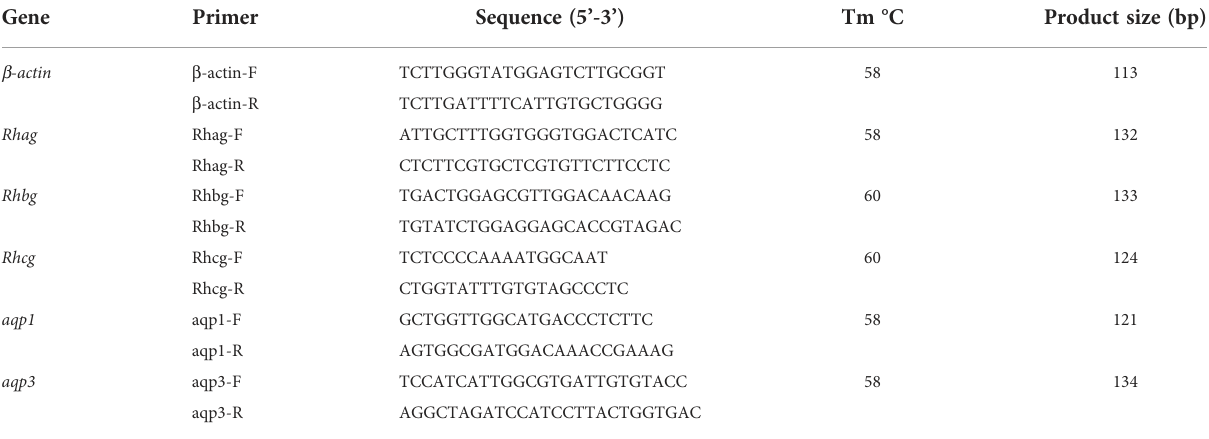
TABLE 1 Primer sequences of detected genes for qPCR.